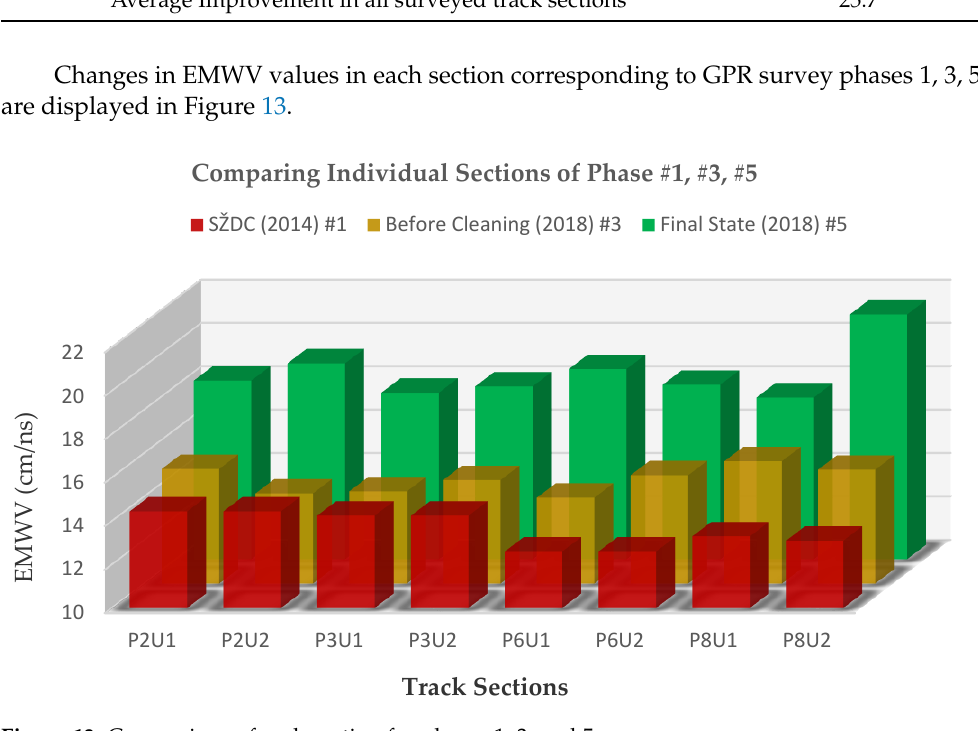
Figure 13. Comparison of each section for phases 1, 3, and 5.